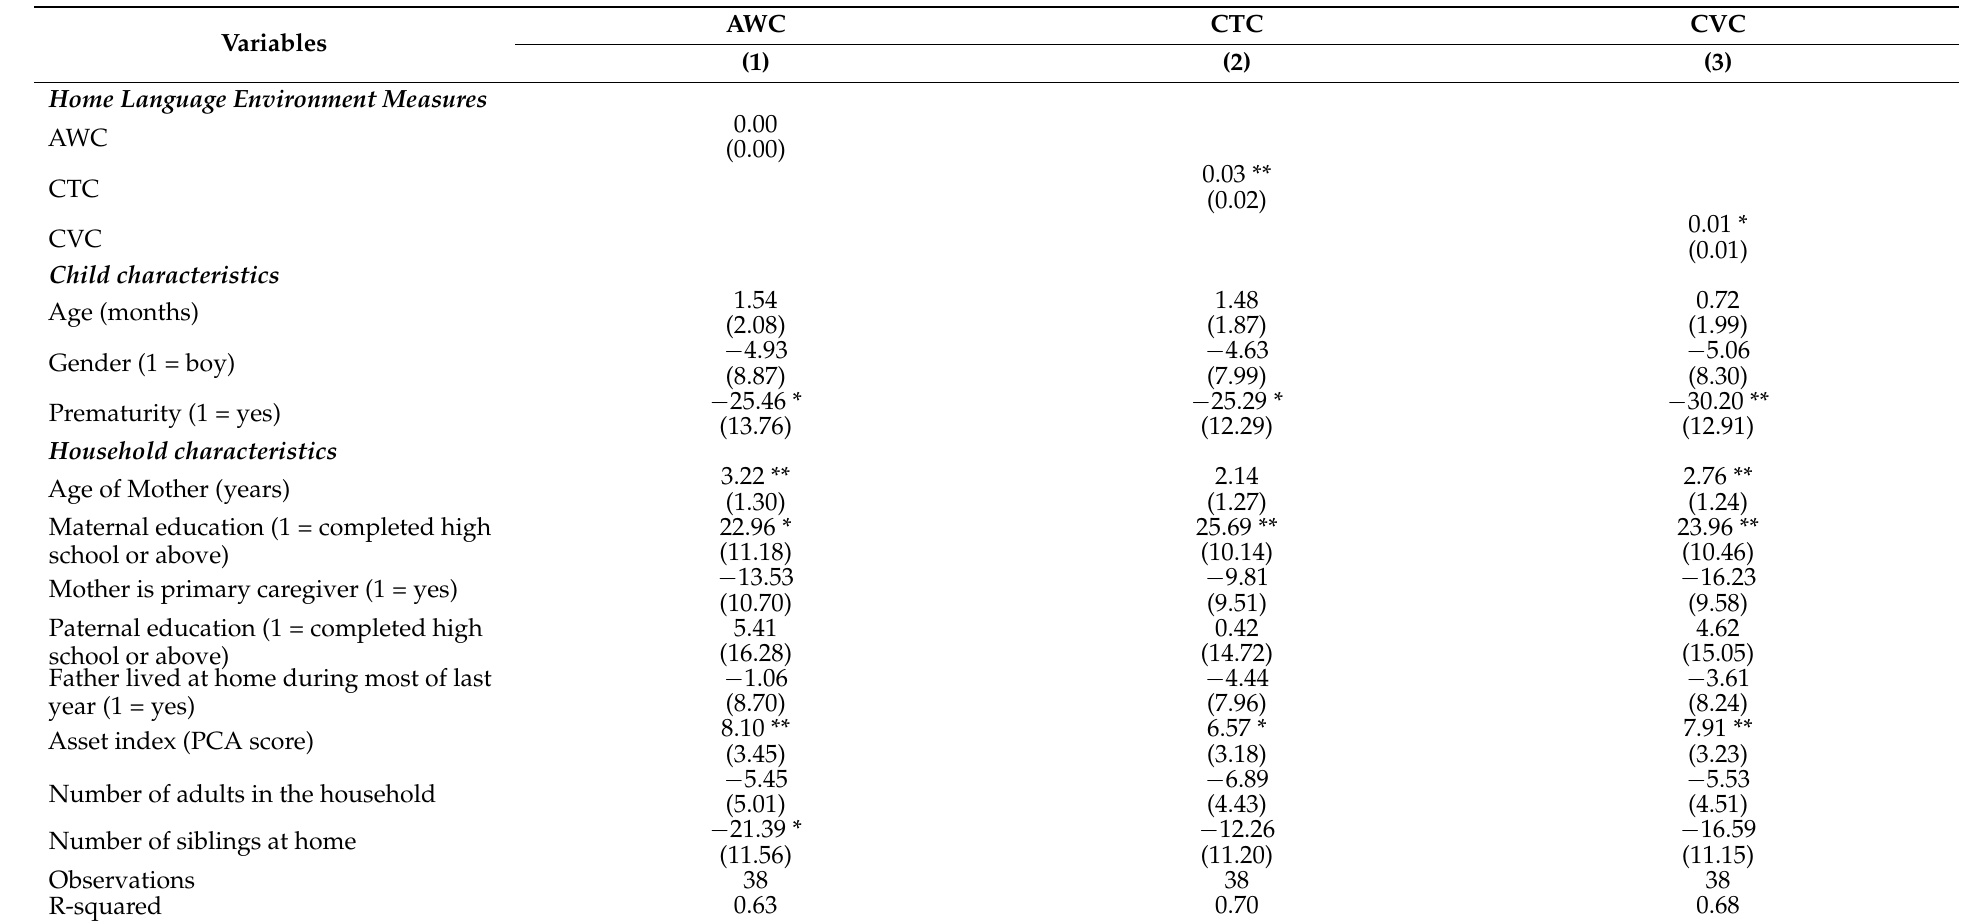
Table 6. Multivariate correlations between AWC, CTC, CVC and